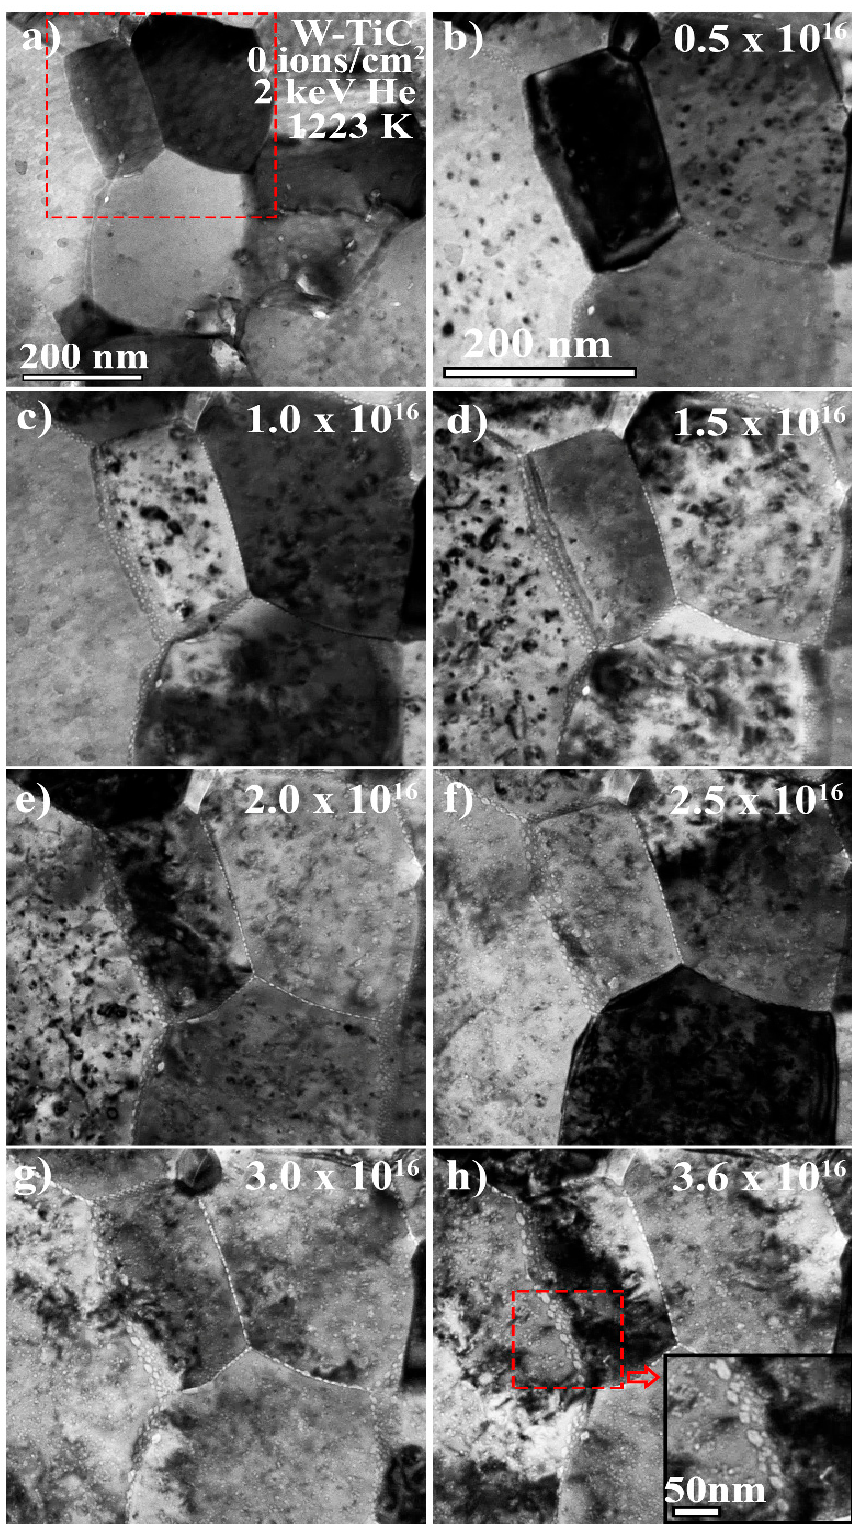
Figure 3. ( a – h ): Bright-field TEM micrographs of a small implanted region taken under Fresnel conditions (under-focused) showing He bubble formation and evolution as a function of He + fluence in the grain matrices and grain boundaries in W-TiC (1.1%) implanted in-situ with 2 keV He + at 1223 K. Scale bar of ( b – h ) is the same and is shown in ( b ). Red box in ( a ) approximately represents a magnified region presented in ( b ) to ( h ).